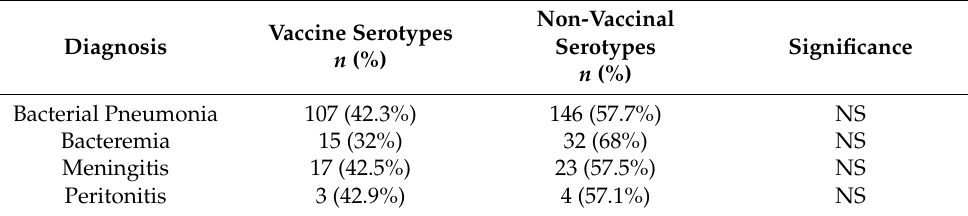
Table 2. Distribution of diagnoses according to serotypes included or not in the PCV-13 vaccine.